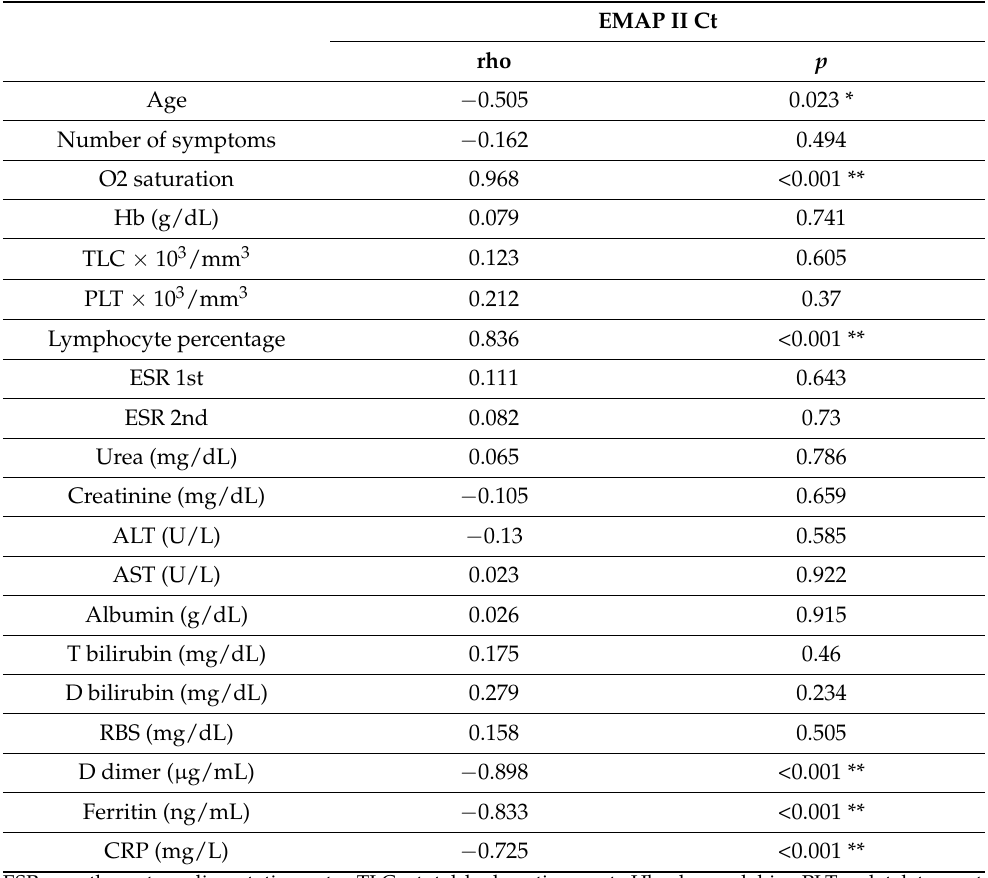
Table 4. Correlation between EMAP II Ct with all parameters in the severe COVID-19 patient’s